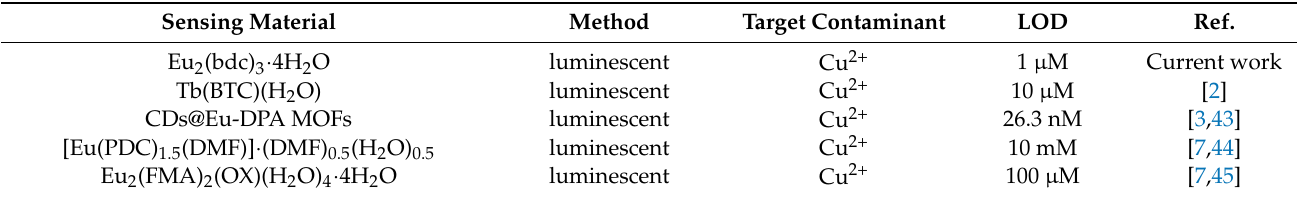
Figure 6. ( a , b ) Photographs of aqueous suspension of coarse-crystalline 1 under 254 nm illumination in the absence and presence of various metal ions; emission spectra of aqueous solution of nanocrystalline 3 in the absence and presence of various concentrations of Cu 2+ ( c ), Cr 3+ ( d ), and Fe 3+ ( e ) ions upon 250 nm excitation; ( f ) Cu 2+ , Cr 3+ , and Fe 3+ concentration dependence of 615 nm emission intensity of Sample 3 . Table 4. Limits of detection (LOD) of nanocrystalline europium(III) terephthalate tetrahydrate 3 and previously reported materials for Cu 2+ , Cr 3+ and Fe 3+